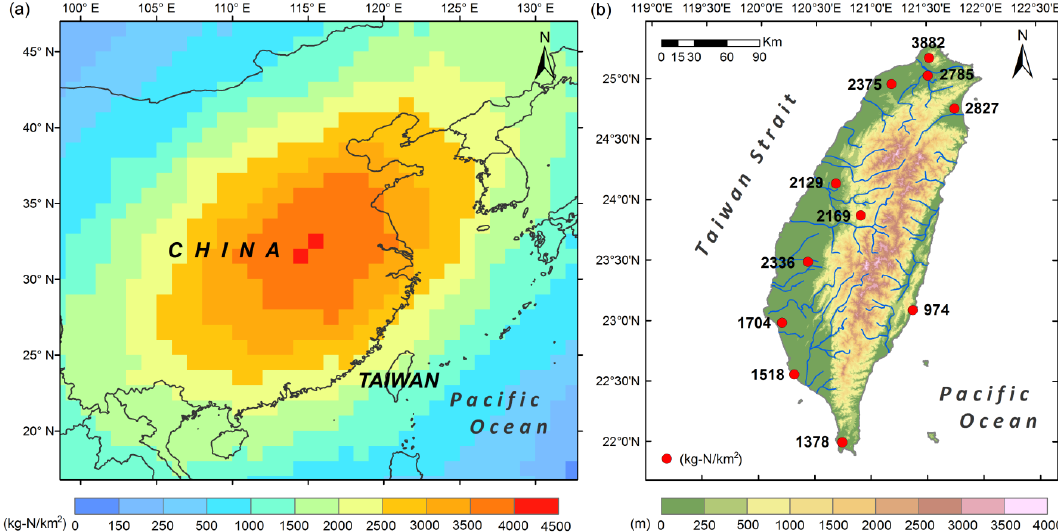
Figure 2. Atmospheric N deposition in East Asia (data set: from ORNL DAAC, NASA, http://daac.ornl.gov) (a) . This data set was generated using a global three-dimensional chemistry-transport model (Lelieveld and Dentener, 2000; Jeuken et al. (2001) re-sampled to 1 ◦ × 1 ◦ ). The observational long-term N deposition (including NO 3 and NH 4 ) in Taiwan (b) . The observed wet deposition is used to estimate the dry deposition by an empirical factor of 0.4 based on Lin (unpublished